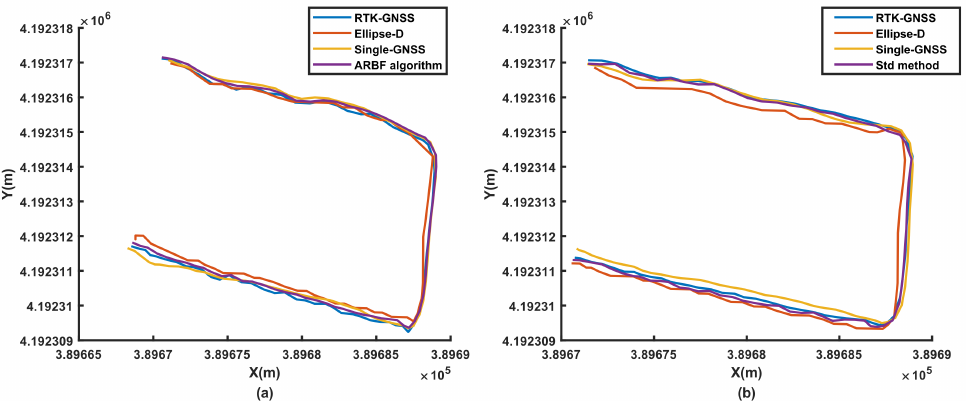
Figure 11. Experimental results from field: ( a ) position prediction results of ARBF algorithm; ( b ) position prediction results of the Std